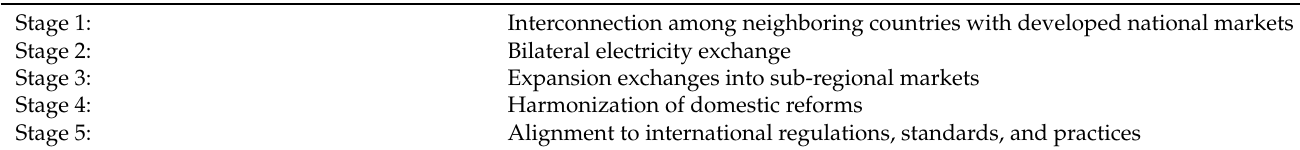
Table 6. Common stages of electricity market